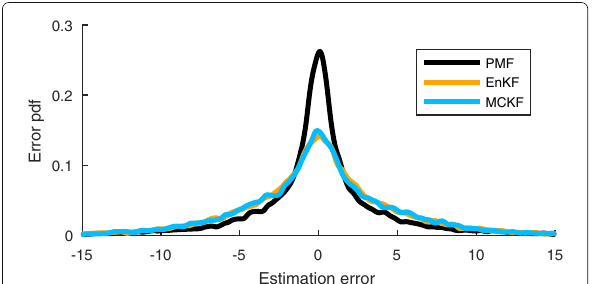
and the process and measurement noise covariances